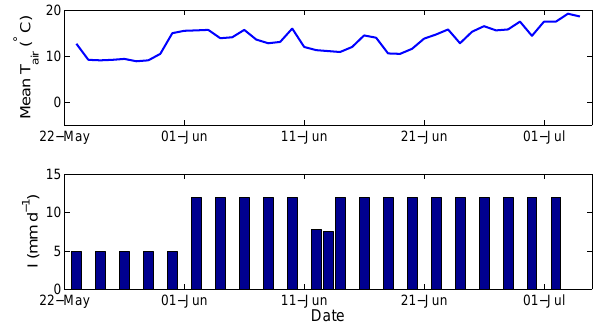
Fig. 3. Weather series for the irrigation experiment (in 2010), mean T air is the daily mean temperature ( ◦ C ), I is the infiltration from irrigation ( mmd − 1 ).